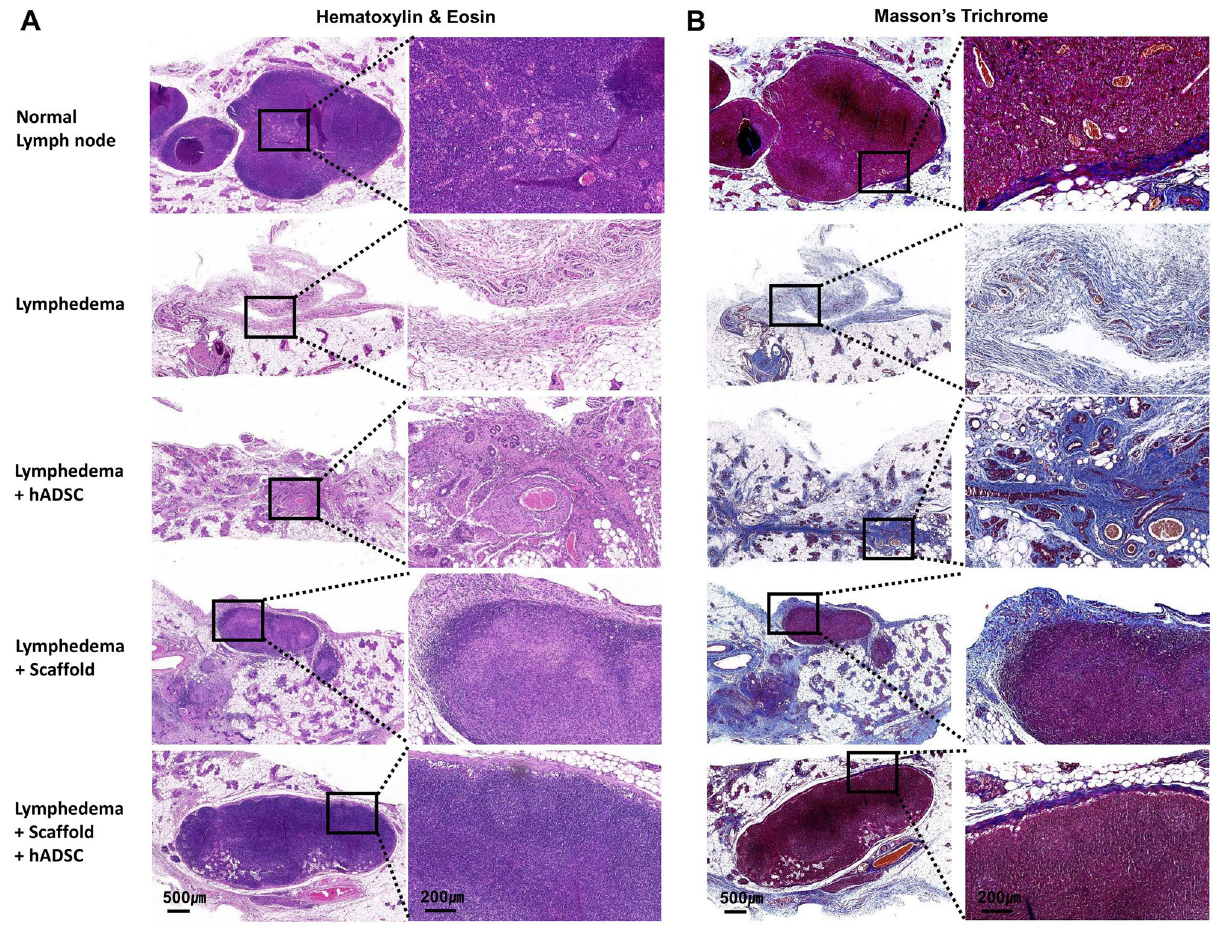
Figure 3. Histopathological observation of recellularizied lymph node scaffold transplantation. ( A ) Hematoxylin and eosin staining of representative inguinal lymph nodes was performed at 14 days postoperatively. No lymph nodes were observed in lymphedema and ADSCs treatment groups, and lymph node scaffolds were observed in scaffold and recellularized lymph node-scaffold groups. ( B ) The inguinal lymph nodes slide sections were stained with Masson’s trichrome; collagen stained blue, muscle stained red, and nuclei stained black. In lymphedema and ADSCs treatment groups, the proportion of collagen was high, but in ADSCs treatment group, some muscle were observed around the ADSCs transplantation. In scaffold and recellularized lymph node-scaffold groups, a collagen layer was observed surrounding the lymph node scaffold, and a large number of cell nuclei were observed in the lymph node. Scale bars: 500 µm, and 200 robust immune response when stimulated with antigen 10 . We hypothesized that recellularization of decellularized lymph node with hADSCs would promote lymph node regeneration with the ability of stem cells. In this study, we tried to overcome the limitation of cell loss by injecting hADSCs into decellularized lymph node scaffolds, culturing recellularized lymph nodes in an incubator for 3 days, and then transplanting them into animals. On the 3rd and 7th days of recellularization, the presence or absence of ADSCs in the recellularized lymph node scaffold was confirmed by staining. Direct injection of hADSCs into the lymph node or around the lymph node has limitations in low cell survival and engraftment due to cell loss. More hADSCs were observed on day 7 than on day 3 in the recellularized lymph node scaffold, indicating that hADSCs were stably engrafted and proliferated on the recellularized lymph node scaffold. We transplanted the recellularized lymph node scaffolds injected with PKH26-labeled hADSCs into lymphedema animals to clearly confirm the cell loss inhibitory effect of the recel- lularized lymph node scaffolds and followed the ADSCs on postoperative day 7 and 14. In the hADSCs group, few hADSCs were observed. However, many hADSCs were observed in the recellularized lymph node-scaffold group. Therefore, it can be said that the strategy of recellularization on the scaffold is more effective than the direct transplantation of stem cells. In histopathological observation, there were no signs of lymph node regeneration in the control and hADSCs groups. However, after transplantation of decellularized or recellularized lymph node scaffolds, lymph node shape was well maintained and lymph node reconstruction was in progress. A large number of hADSCs were observed in the hADSCs injection group, but the lymph node structure could not be regenerated. However, col- lagen deposition and vascular structures were observed around the hADSC injection site, and structures such as lymph node capsules were identified. Previous investigators have reported that hADSCs injection improved